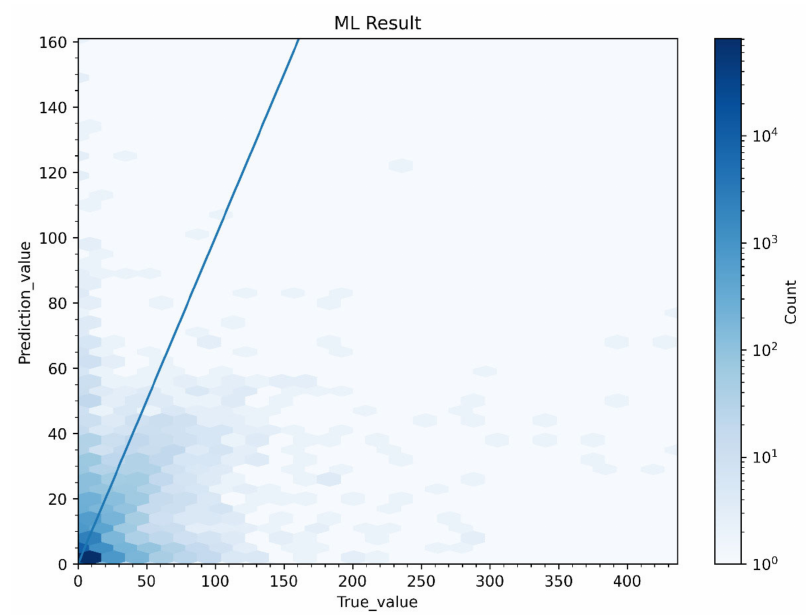
Figure 9. Hexagonal bin plot of the ML